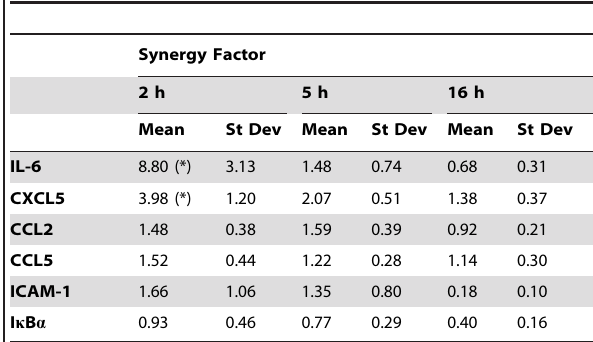
Table 1. Synergy factors upon combined isoproterenol/TNF- a treatment in C2C12 skeletal